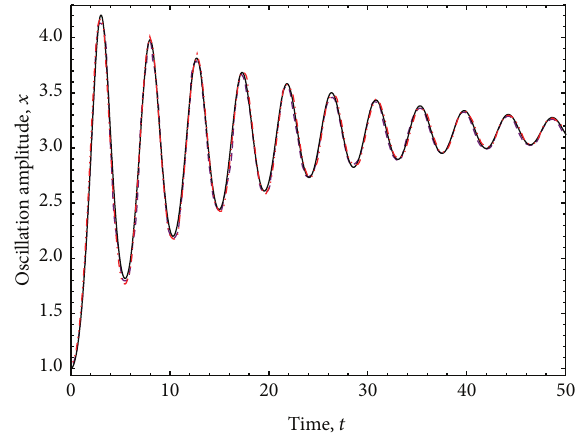
Figure 5: Amplitude-time response curves of (26), (27), and (31). Here, the solid lines represents the numerical integration solution of (18), while the red and purple dashed line represent, respectively, the numerical integration solutions of (27) and (30). The parameter values are ] = 0.1 , 𝐴 = −1 , 𝐵 = 0.1 , and 𝜅 = 0.01 with 𝑥 10 = 1